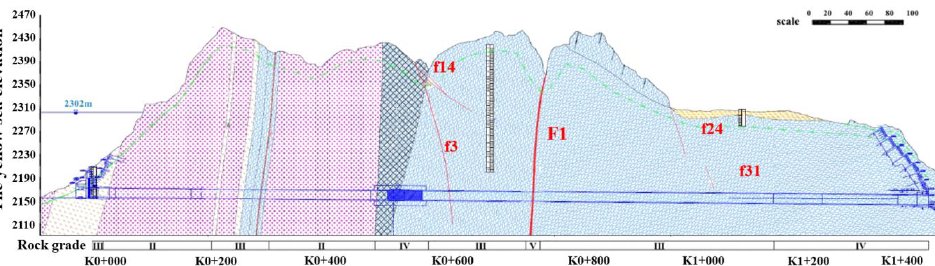
Figure 1. Geological axis profile of the #2 diversion